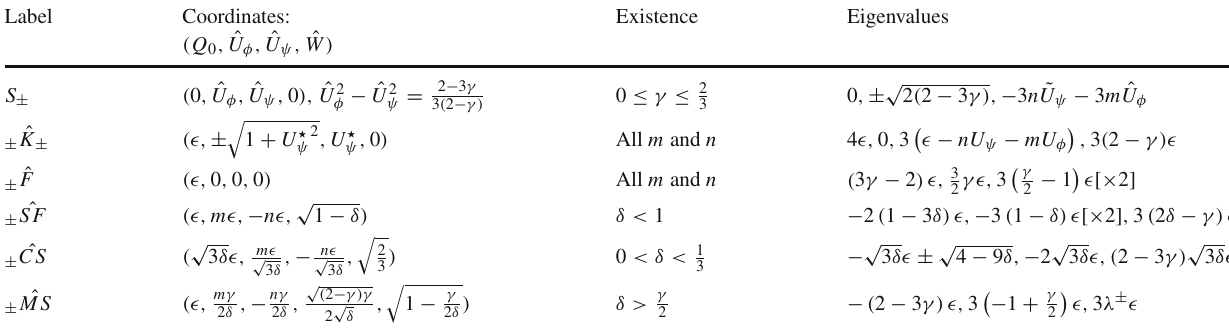
Table 7 equilibrium points in the quintom model with k = + 1 . We use invariant sets Q 0 = ± 1 , the eigenvalues associated to the equilibrium , the set of equilibrium points, the same notation as in Table 5. If γ = 2 points ± ˆ F , ± ˆ SF and ± ˆ MS an to the equilibrium sets ± ˆ K ± , are, in each 3 S , (corresponding to static solutions) reduces to two sets of equilibrium case, the same as those displayed, but the first from the points analogous to V 1 , 2 (see Table 5). When the flow is restricted to the